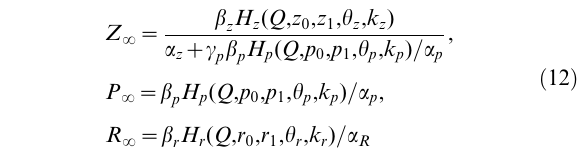
of synaptic inputs. Generally, as we have already mentioned, the impact of this feedback can be bidirectional. The feedback mediated by proteases is implemented in Eqs. (9) as a nonlinear relaxation of the ECM concentration controlled by gain parameter c P .